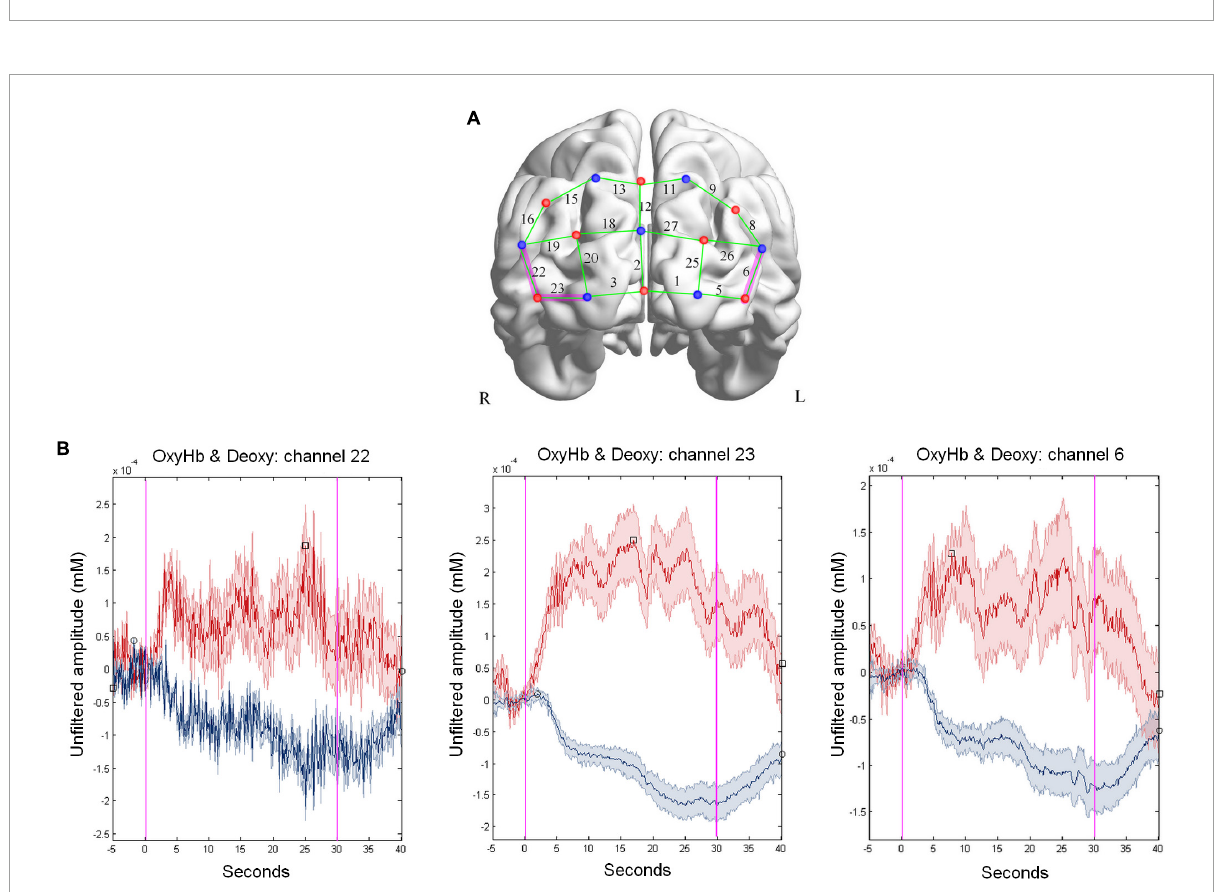
FIGURE6 Group level HbO cortical activation map. (A) 3D-rendered brain template (ICBM152) with left (L) and right (R) hemispheres from BrainNet Viewer toolbox (Xia et al., 2013). The fNIRS channels are positioned across the cortex. The red points represent sources, the blue- points are detectors, and the green lines are channels. The purple highlight indicates the channel associated with the correlation between deoxy-Hb variation and mental rotation task (MRT). Thresholded SPM t image, p -value = 0.0025 for deoxy-Hb. (B) Block-averaged hemodynamic response (mean ± SD) computed by averaging the oxy-Hb (red) and deoxy-Hb (blue) signals during the MRT for channels 6, 22, and